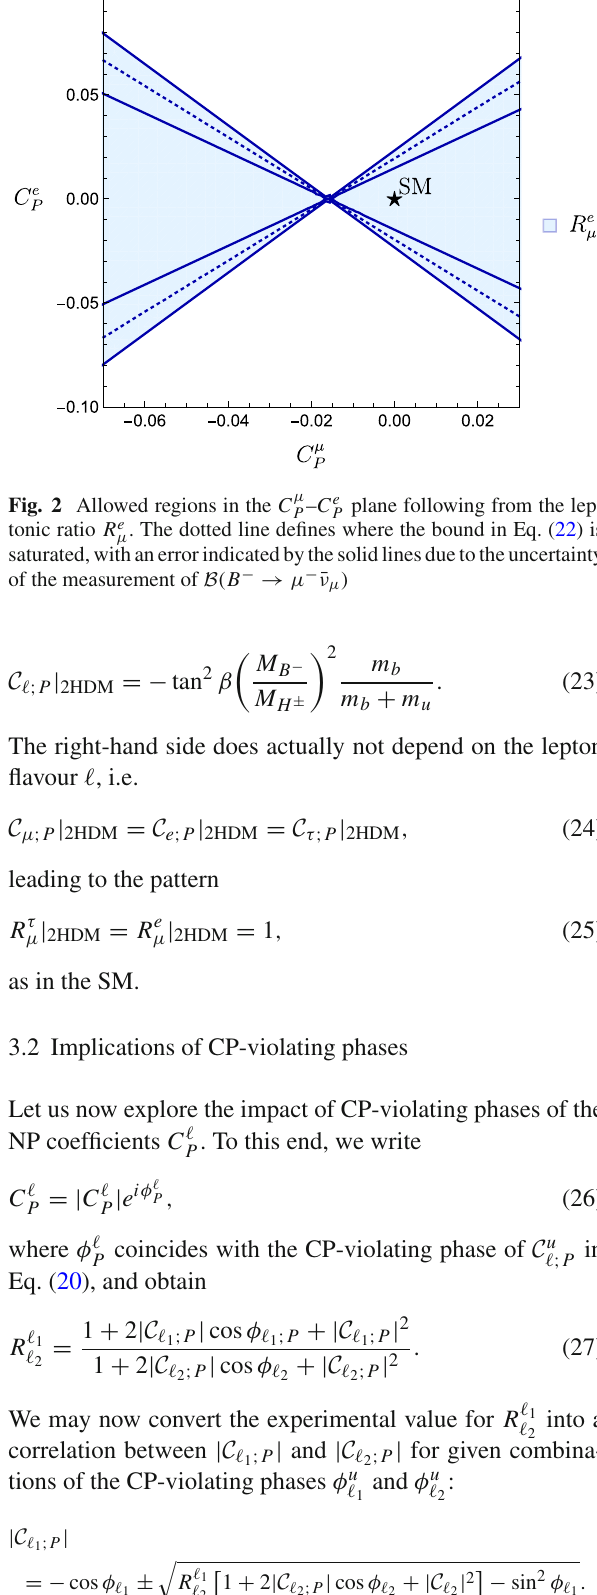
μ – C τ plane following from the lep- P P